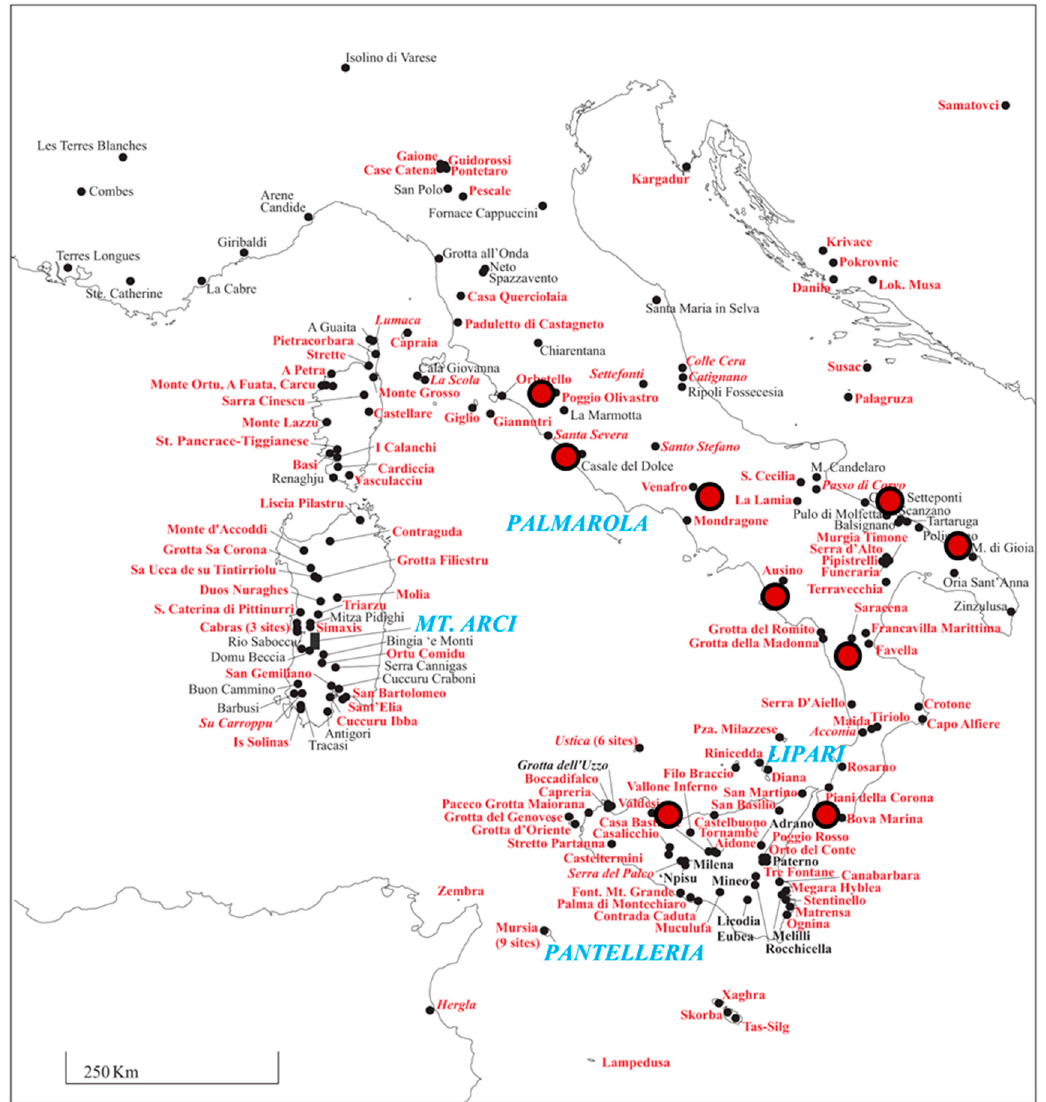
Figure 11. Map with sites in southern Italy with Sardinia obsidian artifacts. From north to south, in red circles: Poggio Olivastro 20/100 (20%); Casale del Dolce 1/35 (3%); Venafro 1/132 (<1%); Pulo di Molfetta 1/37 (2.7%); M. Di Gioia 12/12 (100%); Ausino 3/21 (14%); Saracena 4/842 (<1%); Bova Marina 1/200 (<1%); Valdesi 1/41 (2.5%).